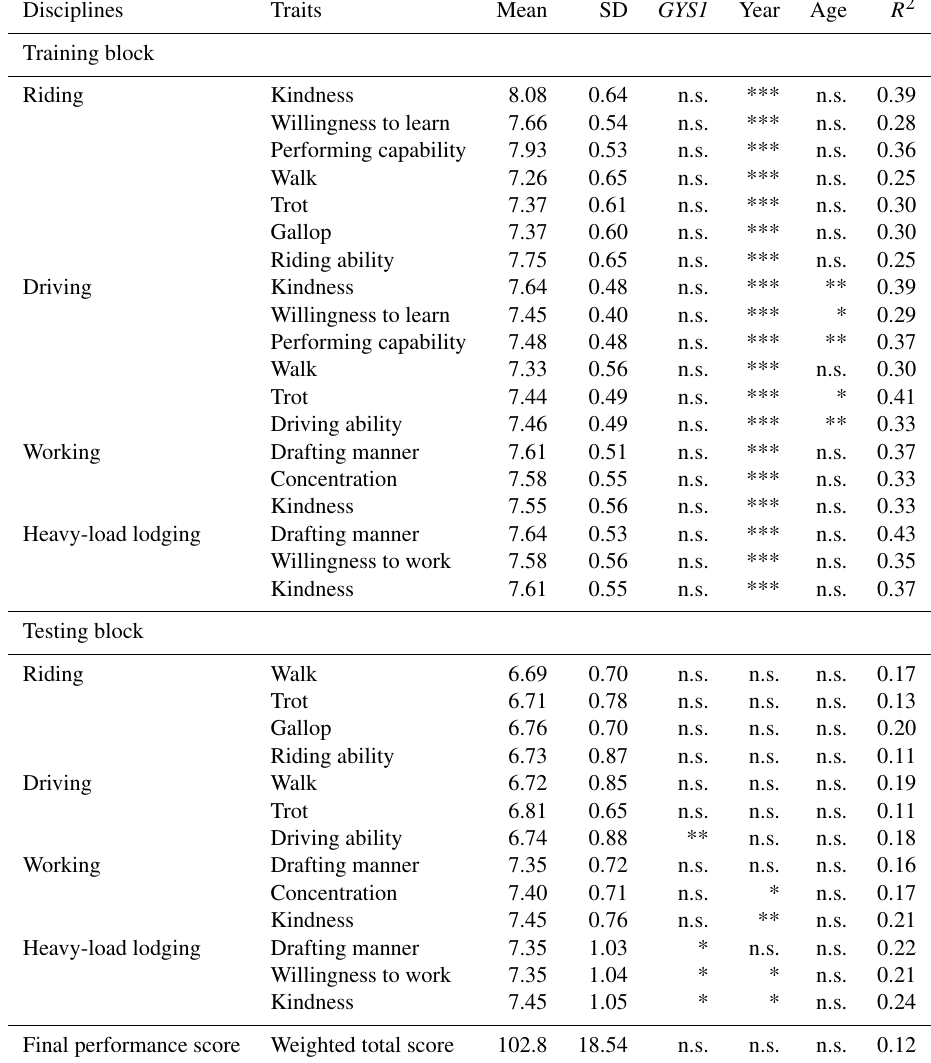
Table 1. Mean values, standard deviations (SDs), significance levels for the effects of the linear model, and level of determination ( R 2 ) for performance traits within the training block and testing block of the performance test for 169 Noriker